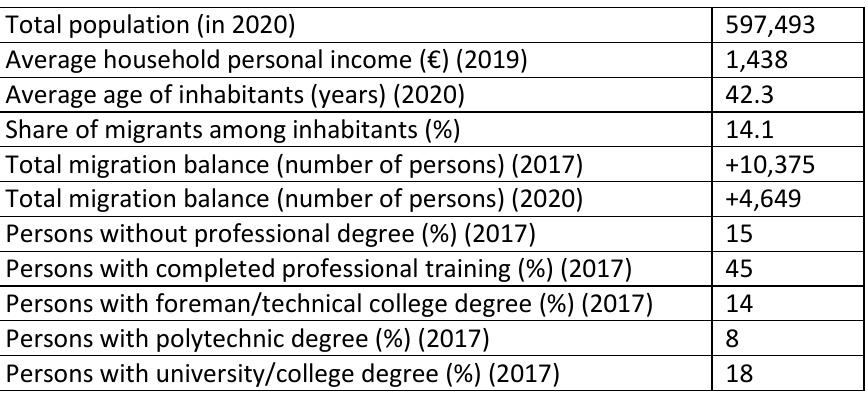
Table A3.4: Selected socio-demographic data of